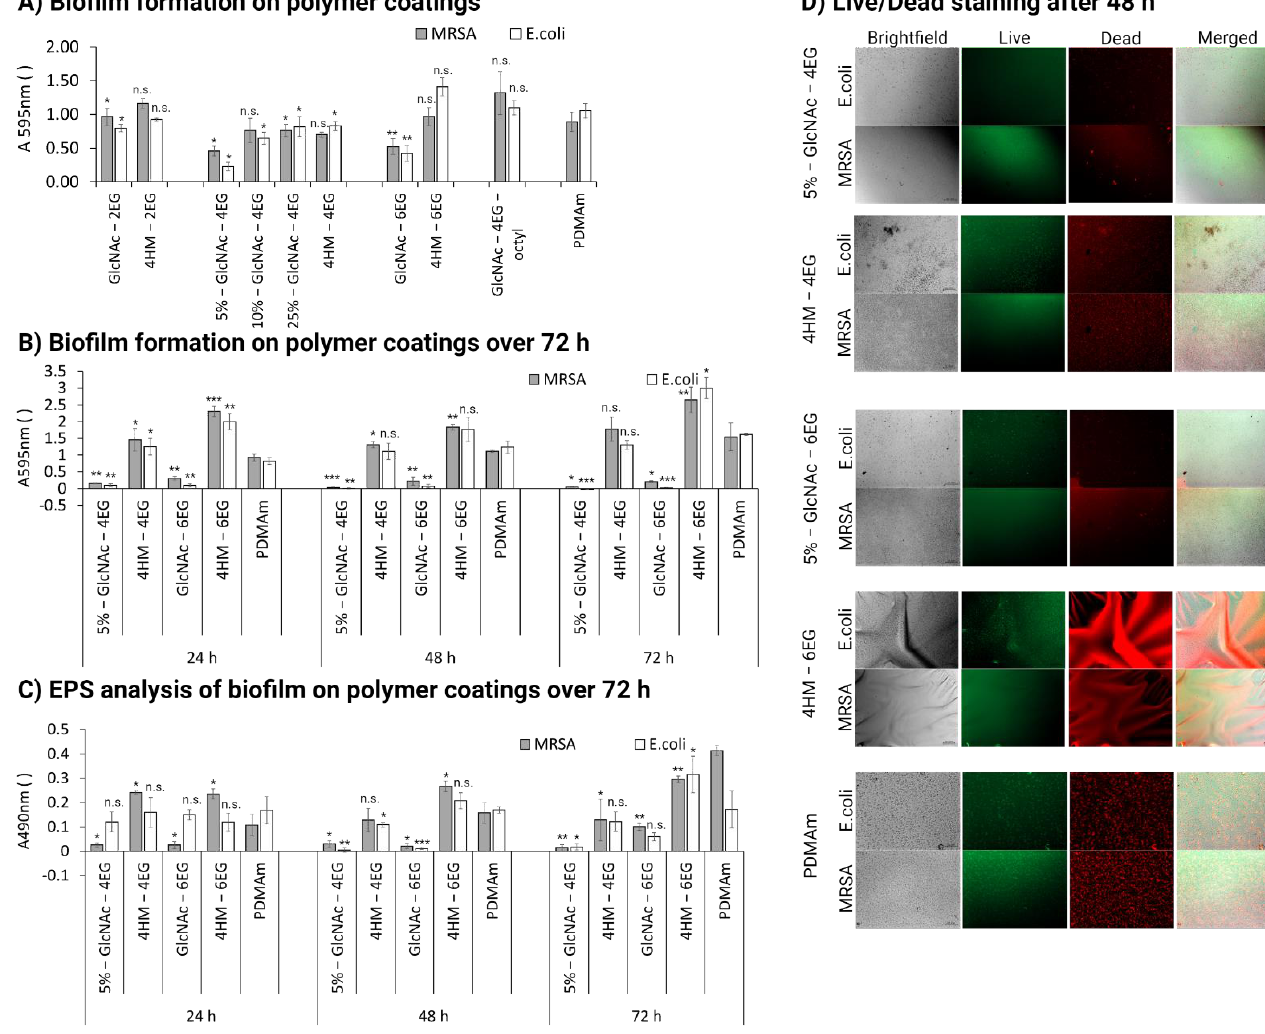
Figure 6. Evaluation of biofilm formation of polymer coatings. PDMAm corresponds to the unmodified acrylate coating. ( A ) Biofilm formation of E. coli and MRSA in the high-nutrition environment was assessed by crystal violet staining after 24 h of cultivation for all coatings as a first evaluation. ( B ) Biofilm formation of E. coli and MRSA in the high-nutrition environment was assessed by crystal violet staining after 24, 48 and 72 h of cultivation for the most active polymer coatings and their respective controls. Corresponding brightfield images are available in the supplementary materials (Figure S1) ( C ) Extracellular polymeric substance (EPS) analysis of formed biofilm by E. coli and MRSA in the high-nutrition environment was assessed by phenol-sulfuric acid method after 24, 48 and 72 h of cultivation for the most active polymer coatings and their respective controls. ( D ) Live/Dead staining of E. coli and MRSA in the high-nutrition environment after 24, 48 and 72 h of cultivation for the most active polymer coatings and their respective controls. Magnification is 100 × ; scale bar measures 0.1 mm. Values are shown as mean ± SD. Significant changes were assessed by pairwise Student ´ s t -test (n.s., not significant; * p < 0.05; ** p < 0.01; *** p <